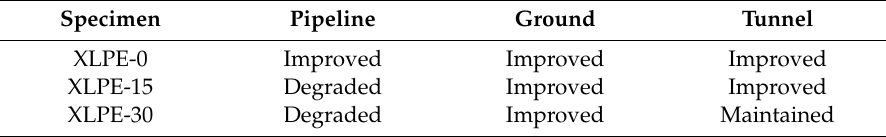
Table 5. Status of the crystal structure of the specimens after thermal effects.